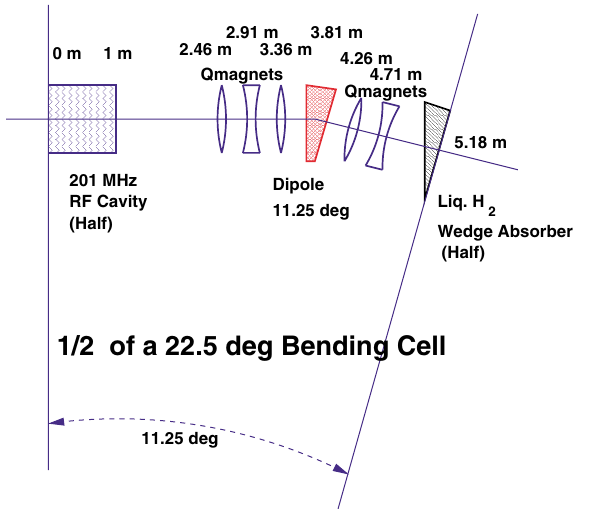
FIG. 40. (Color) Schematic diagram of half of a 22 : 5 (cid:28) bending cell. A wedge absorber is located in the middle of the cell. Fig. 40 where the elements of a half-cell for a 22 : 5 (cid:28) bending cell are depicted schematically. The correspon- dence between the beam envelope beta and dispersion functions resulting from a simulation with the ICOOL tracking code and the SYNCH calculated values are shown in Fig. 41. The full 16-cell ring is shown in Fig. 42.